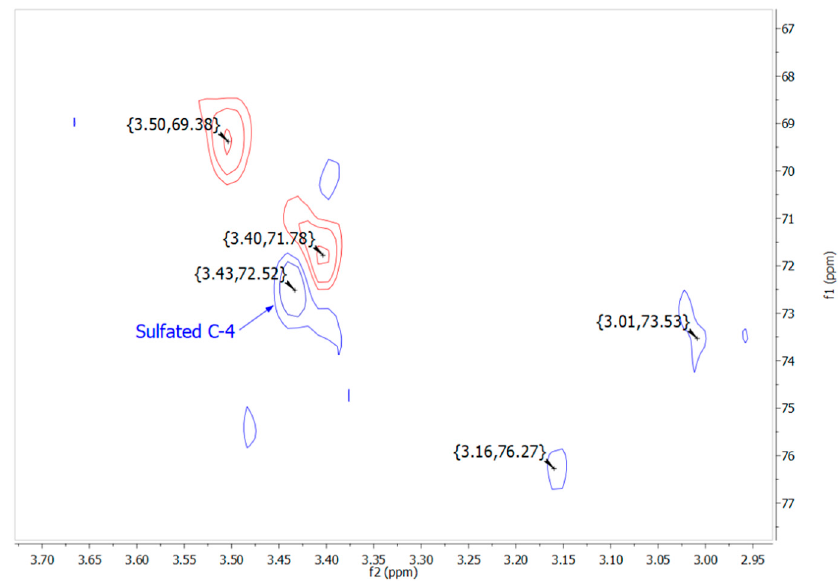
Figure 5. 1 H- 13 C HSQC spectrum of CM-S-BOT-1. Region of non-anomeric glucosyl carbon atoms is shown. (full spectrum is shown in the Supplementary Material Figure S2).